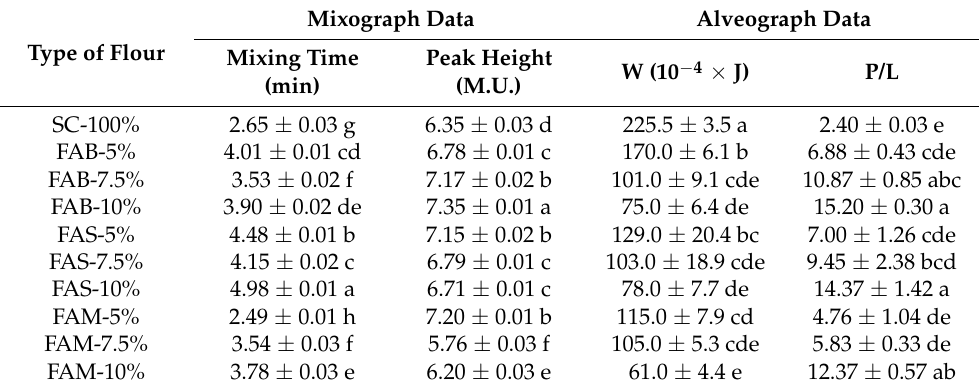
Table 4. Mixograph and alveograph data of re-milled semolina (control) and of mixes prepared at increasing levels of replacement (5, 7.5, 10%) with flours from artichoke stems and bracts.